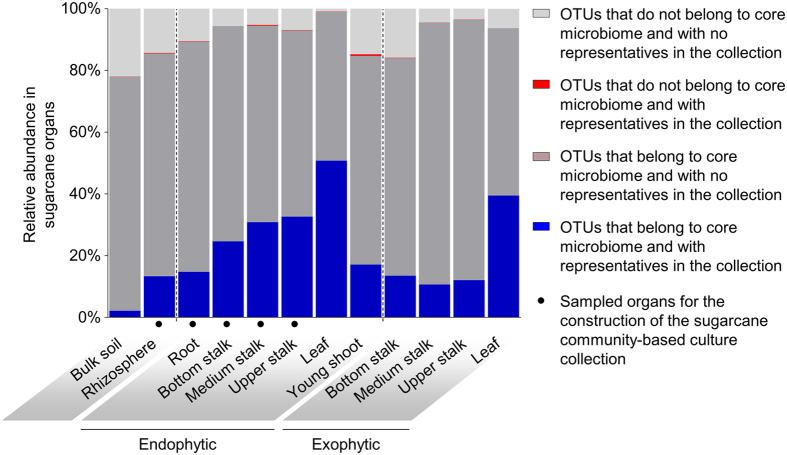
Estimation of microbial community recovery in community-based culture collection (CBC).The graph shows an estimate of the relative abundance represented by the isolates in five plates of the CBC. The estimate was calculated based on cross-reference between the OTUs from CBC and sugarcane microbial profile23 (Supplementary Note). The taxonomical overlap of plant organs made possible to find representatives of the microbial community from plant organs that were not sampled for construction of the sugarcane CBC.